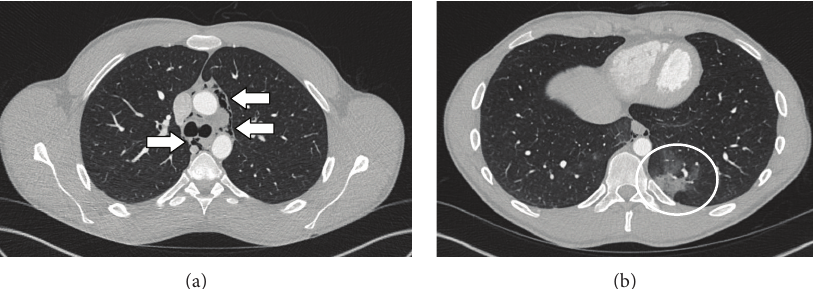
Figure 2: Chest computed tomography showing air outlining mediastinal structures (arrows) and a small pulmonary contusion on the left side